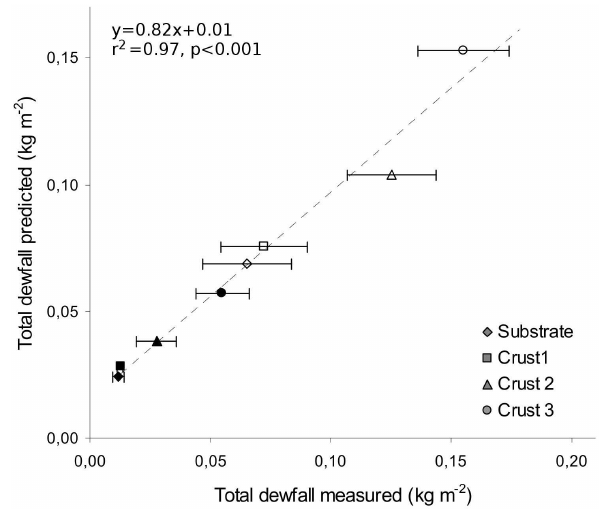
Fig. 2. Measured and predicted amounts of cumulative dew in the Figure 2 Measured and predicted amounts of cumulative dew in the initial substrate and in the 454 initial substrate and in the crusts 1, 2 and 3; 2–8 August 2011 (blank crusts 1, 2 and 3; 02-08.08.2011 (blank symbols) and 17.-18.08.2011 (filled symbols). 455 symbols) and 17–18 August 2011 (filled symbols). Arithmetic mean Arithmetic mean values with n=3, error bars indicate standard deviation. 456 values with n = 3; error bars indicate standard